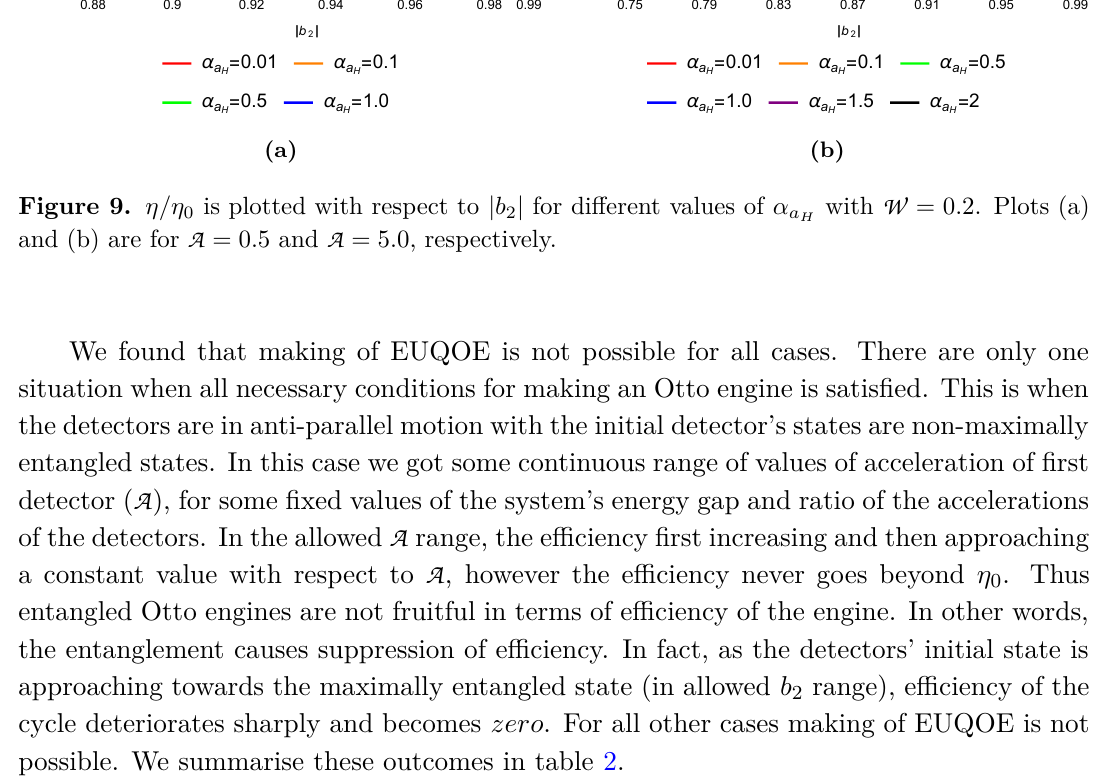
with W = 0 . 2 . Plots (a) H